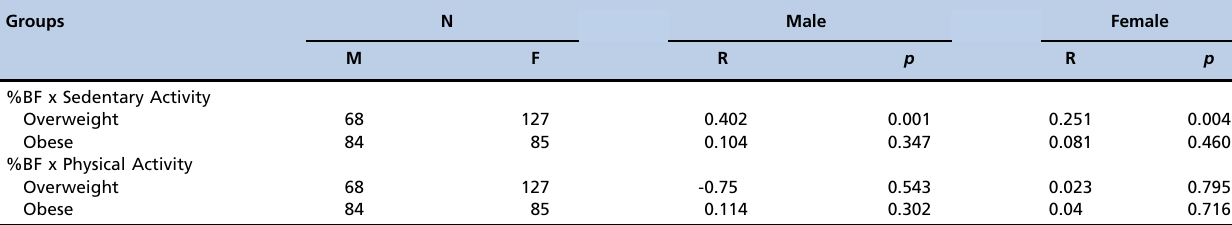
Table 3 - Correlations between %BF and time of sedentary activity in hours/week and between %BF and time of physical activity in minutes/week grouped by gender, according to the nutritional status of school children in Uberaba (MG).